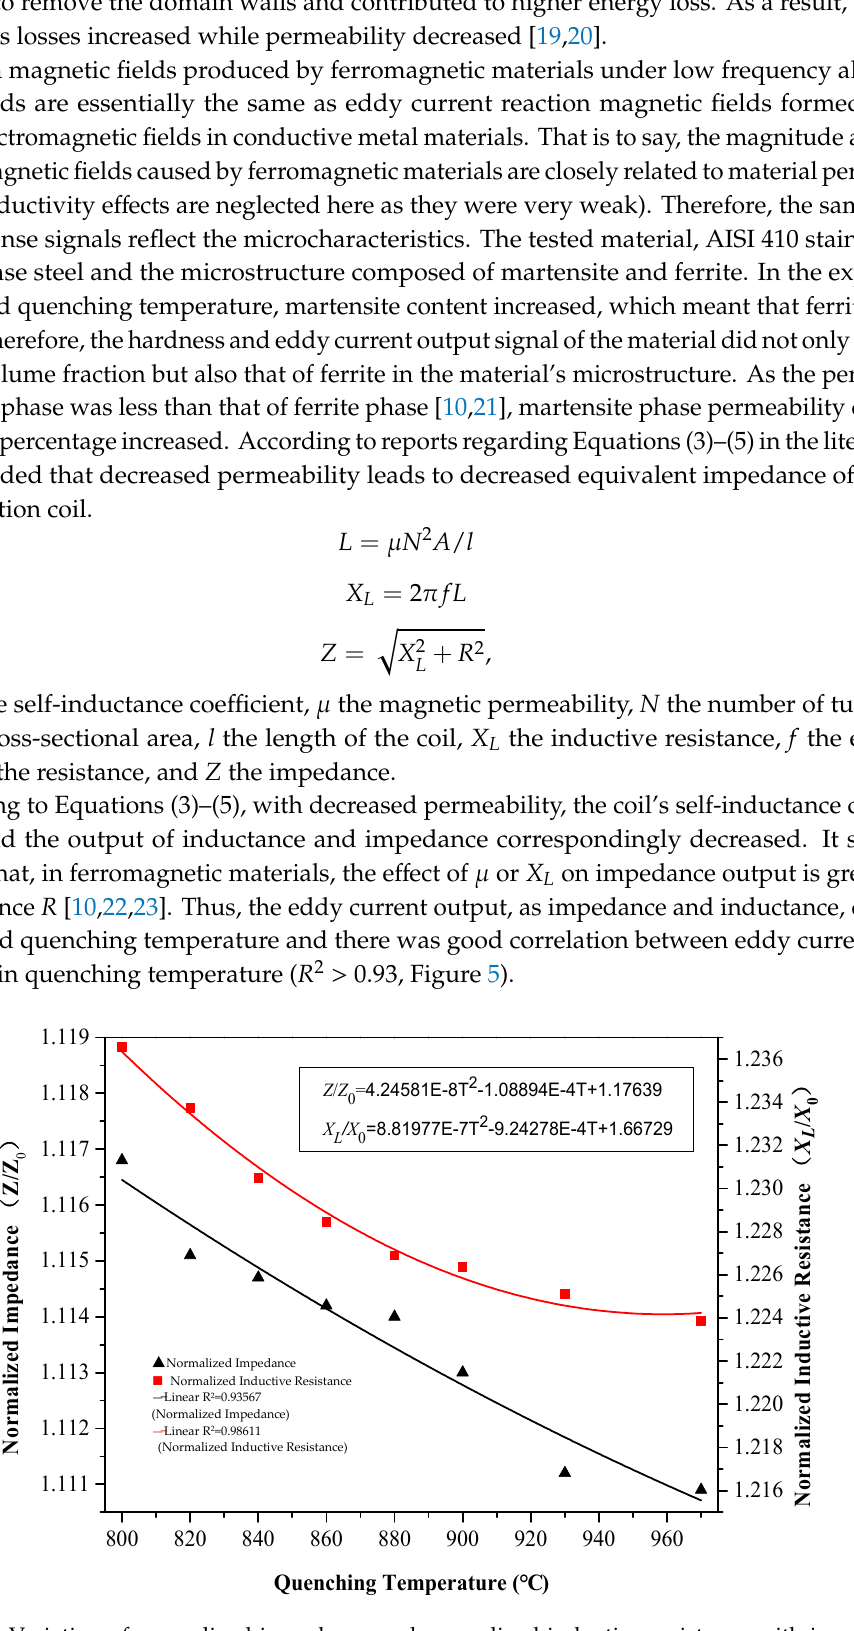
Figure 5. Variation of normalized impedance and normalized inductive resistance with increased quenching